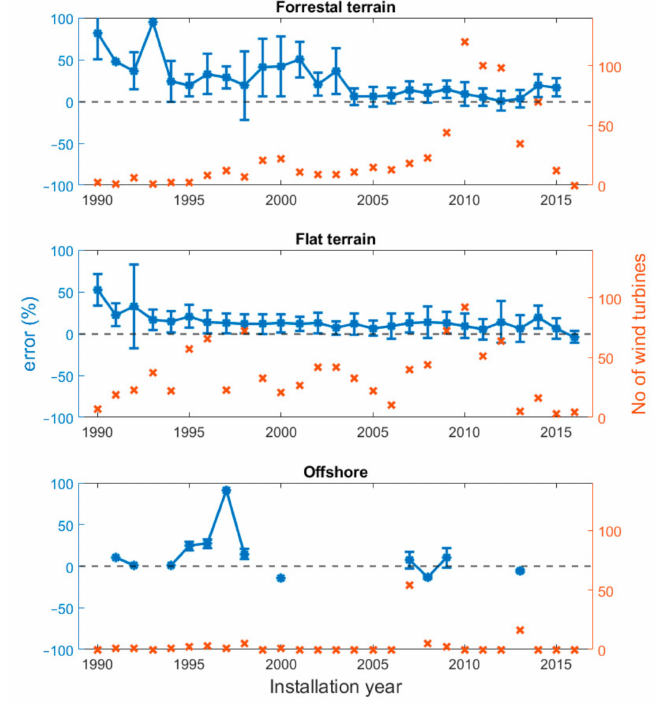
Figure 6. The time development of the AEP prediction accuracy divided on terrain type with number of wind turbines for each year.